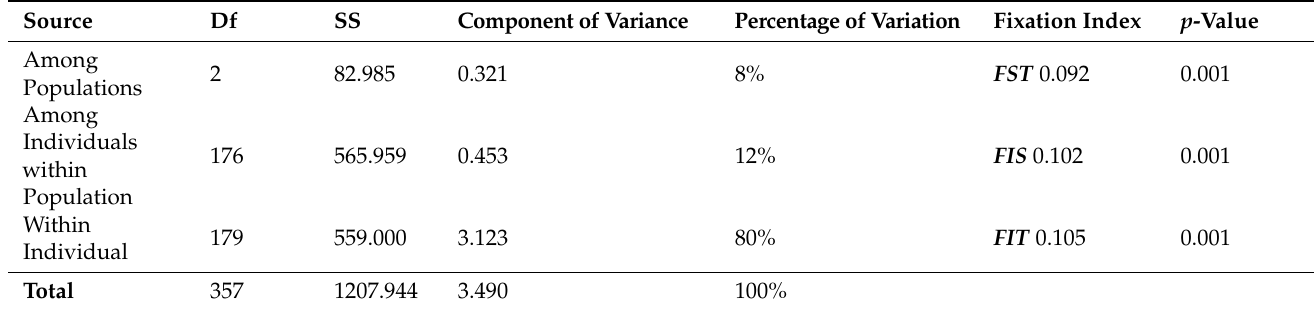
Figure 5. Population structure analysis: the population of 180 Z. nummularia genotypes with K = 3 clusters based on 27 SSRs primers. Note; the sub-figures represented relationship with other districts genotypes respectively. Table 5. AMOVA (Analysis of molecular variance) for the 180 Z. nummularia genotypes.